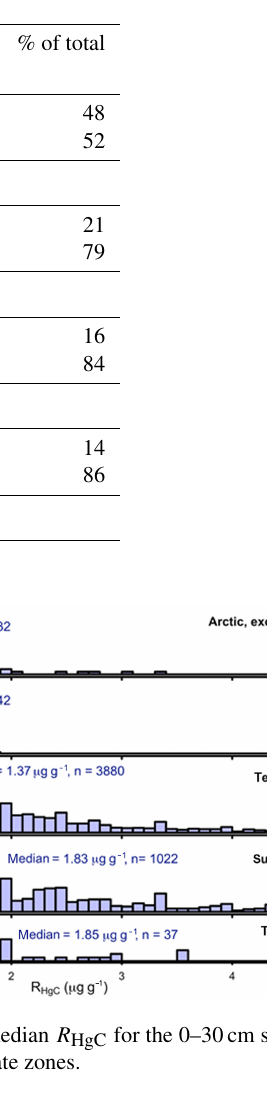
Table 2. Estimated pan-Arctic permafrost soil Hg inventory (Gg) for different depth ranges down to 300cm. Hg pool uncertainties are reported as the interquartile range (IQR), i.e., the 25th to 75th percentiles of the Hg pool distribution estimates by a Monte Carlo method. Soil organic carbon (SOC) pools are from Hugelius et al. (2014).